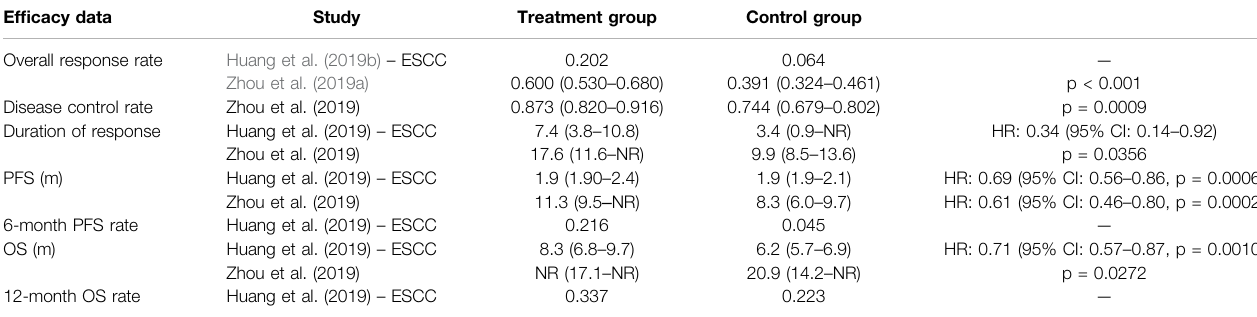
TABLE 5 | Ef fi cacy data of two enrolled randomized controlled trials. Ef fi cacy data Study Treatment group